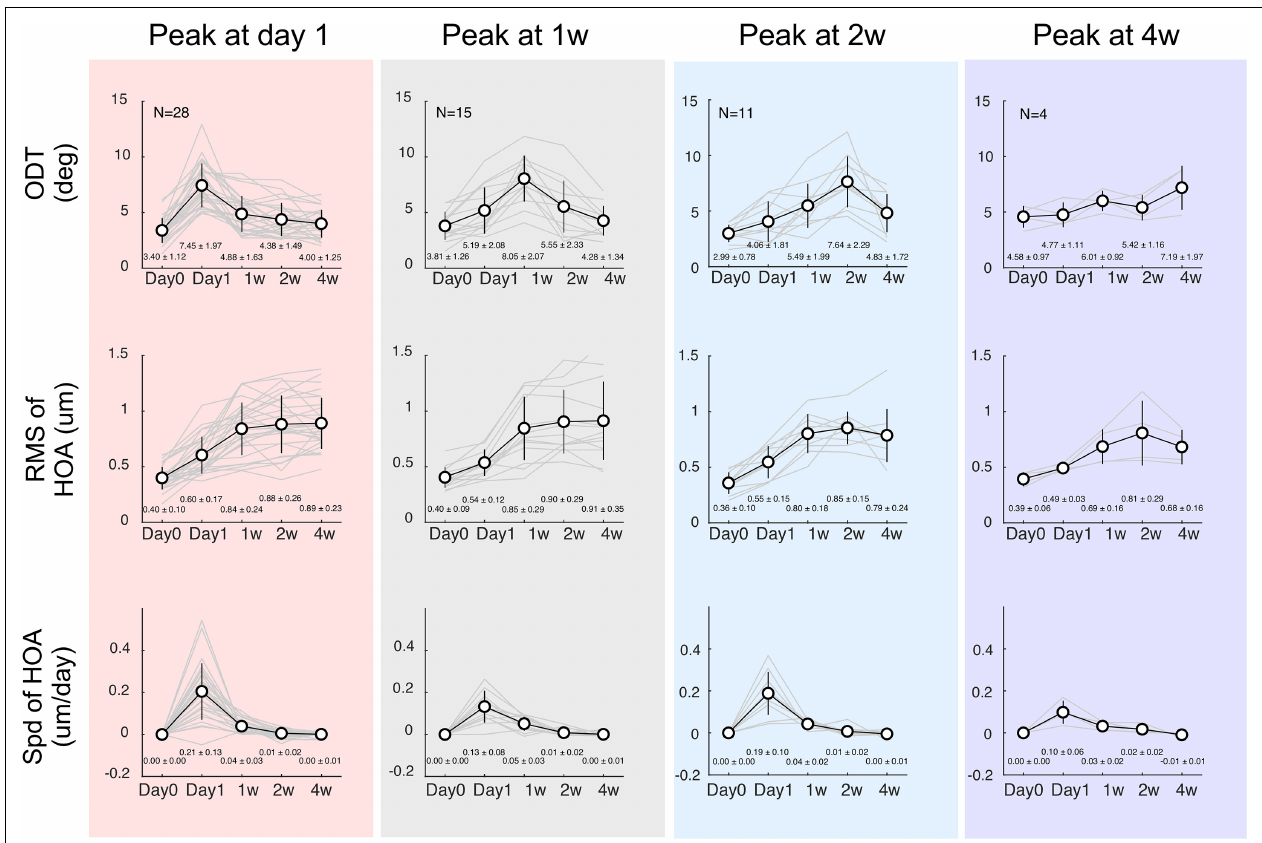
FIGURE 3 | Time courses separated according to the ODT peaking time. Top row: discrimination threshold (ODT), Middle row: Residua Mean Square (RMS) of high-order aberrations (HOA), Bottom row: changing speeding of HOA. The left column shows subjects whose ODT peaked at day 1 (red shade); the middle column shows subjects whose ODT peaked at 1 week (gray shade), and the right two columns show subjects whose ODT peaked at 2 weeks (blue shade) or 4 weeks (purple shade),